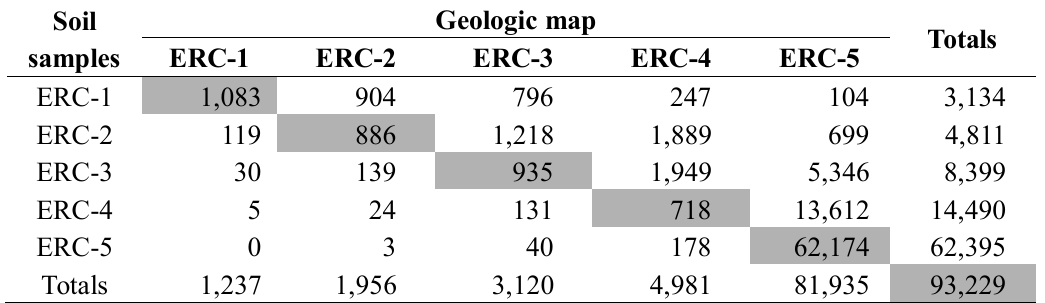
Table 4. Cross-tabulation matrix of ERC derived from the alternatives (number of